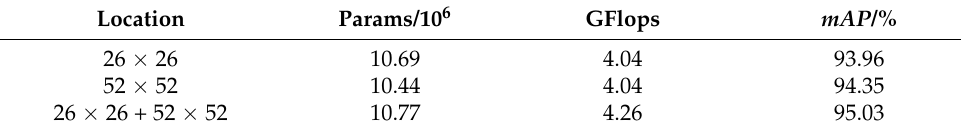
Table 6. Comparison of model accuracy for adding RFB additions at different